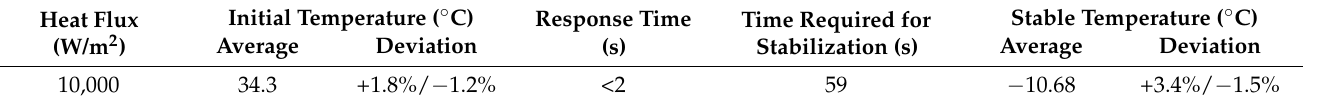
Table 9. Experimental data of three stages under the heat flux of 10,000 W/m 2 .